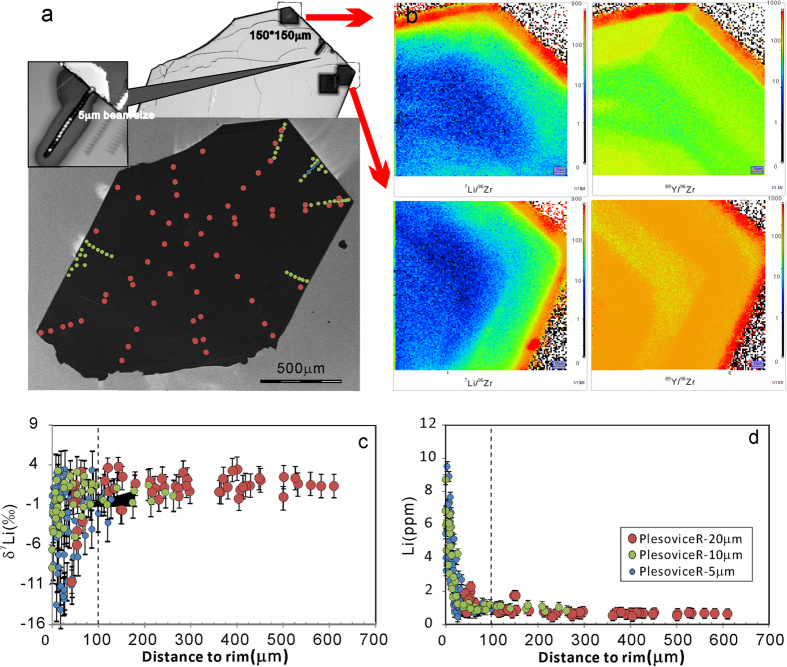
(a) Trace outlines on the CL image of Plešovice-R to show the position of the Li isotopic and [Li] measurements by SIMS. (b) The ion image of the variation of Li and Y content (bright colors = higher concentration). (c) δ7Li vs relative distance to the rim. (d) [Li] vs relative distance to the rim. Uncertainty of standard analysis (2SD) has been shown in the plots while 2SE of individual analyses is smaller than 2SD. Typical analytical uncertainty of δ7Li is ∼2‰ for the 20 μm pits, ~2.5‰ for the 10 μm pits and ∼5‰ for 5 μm pits (2 SD). Distance to rim is calculated by the X-Y position of the analytical spot to the nearest rim.